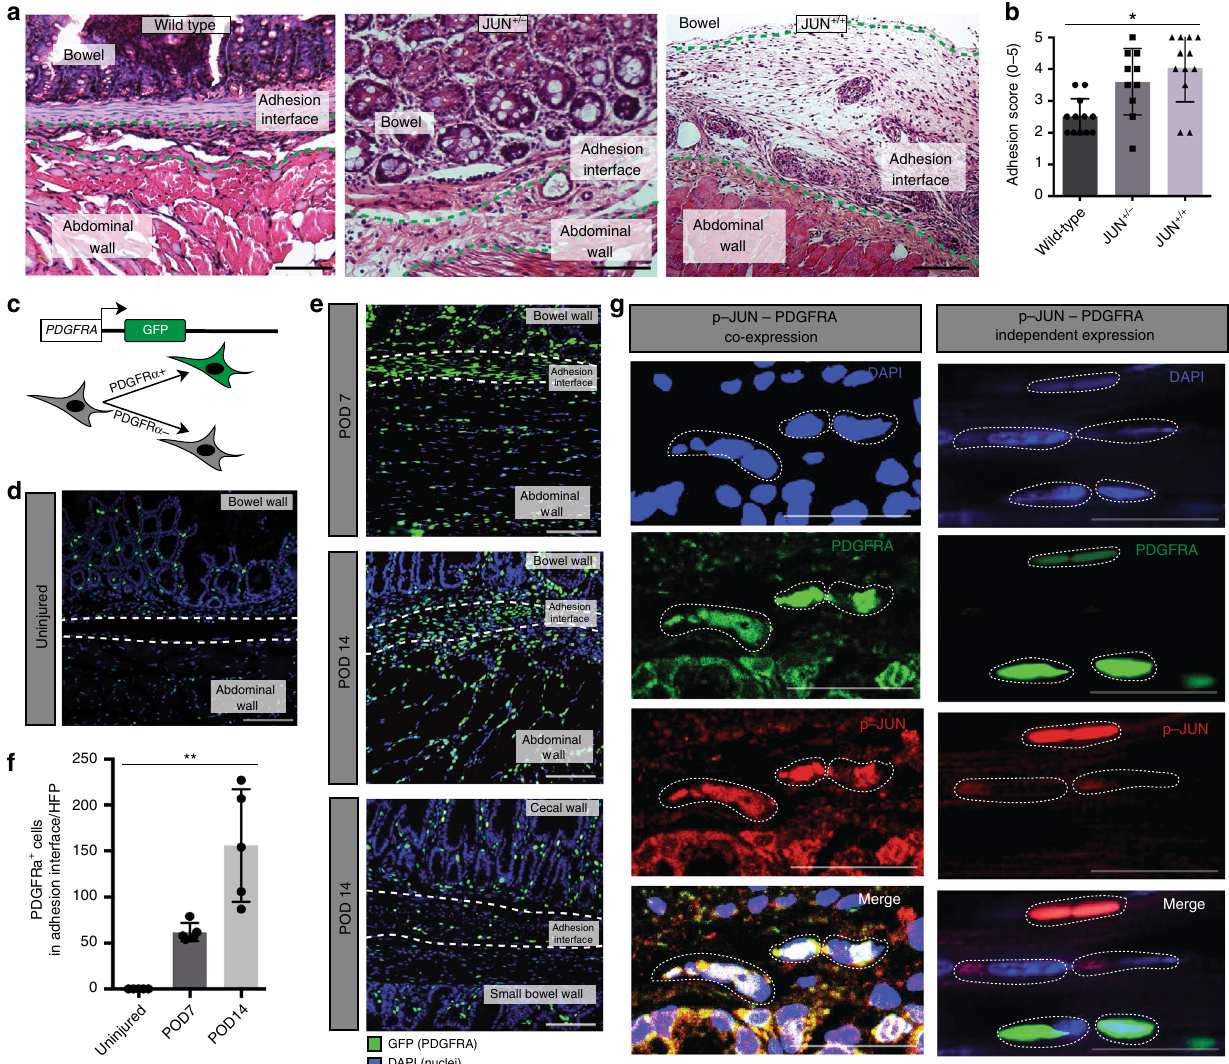
Fig. 1 JUN promotes adhesions and upregulates PDGFRA expression. a Representative samples of hematoxylin and eosin (H&E) stained abdominal adhesion tissue specimen from JUN + / + (right panel), JUN + / − (middle panel) and wild-type mice (left panel). Green dotted lines outline adhesion interface, structures as labeled in fi gure. n > 10 biological replicates. Scale bars, 100 μ m. b Application of an objective histologic adhesion rating score by blinded pathologists (based on to the gross score used by Tsai et al. (2018) 19 and the histologic score used by Linsky et al., (1987) 36 ) quanti fi es relative adhesion severity in wild-type, JUN + / − , and JUN + / + mouse specimens. n = 10 biological replicates. c Schematic of the PDGFRA GFP mouse construct. d Fluorescent imaging of PDGFRA GFP mouse uninjured (control) visceral and parietal peritoneum. Structures as labelled in fi gure, white dotted lines outline area of potential adhesion interface, POD postoperative day. n = 10 biological replicates. Scale bar, 100 um. e Fluorescent imaging of PDGFRA GFP mouse adhesion tissue at POD 7 (top panel), POD 14 (middle panel — visceral-parietal adhesion, bottom panel — visceral-visceral adhesion). Structures as labelled in fi gure, white dotted lines outline adhesion interface. GFP green fl uorescent protein. n > 5 biological replicates. Scale bars, 100 μ m. f Quantitation of GFP + (PDGFRA GFP ) cells per high power fi eld (HPF) in the adhesion interface in mouse adhesions (from Fig. 1d, e). n = 5 biological replicates. g Immuno fl uorescent staining of representative samples shows PDGFRA and phospho (p)-JUN colocalization (left panels) and independent expression (right panels) within the adhesion interface. Individual panels at top, merge in bottom row, white dotted lines highlight cells of interest. Scale bars, 25 μ m. Data and error bars represent means ± standard deviation (SD). * P = 0.0009 (one-way Anova), ** P = 0.0001 (one-way Anova). Source data are provided as a Source Data fi